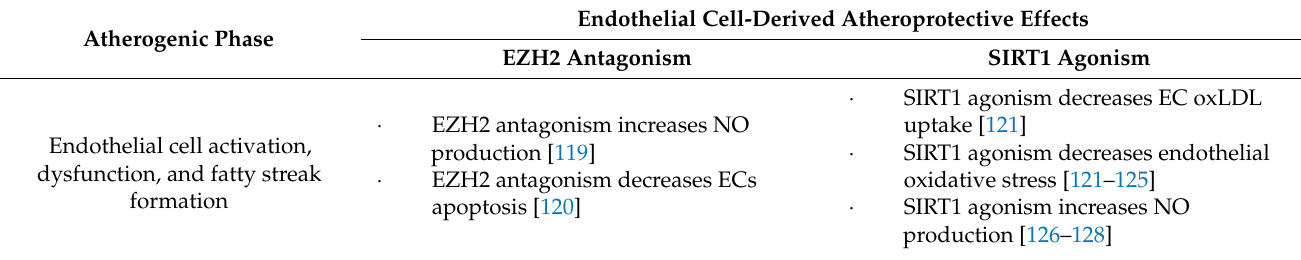
Table 2. Endothelial cell-mediated antiatherogenic effects induced by EZH2 antagonism or SIRT1 agonism. Endothelial Cell-Derived Atheroprotective Effects Atherogenic Phase EZH2 Antagonism SIRT1 Agonism